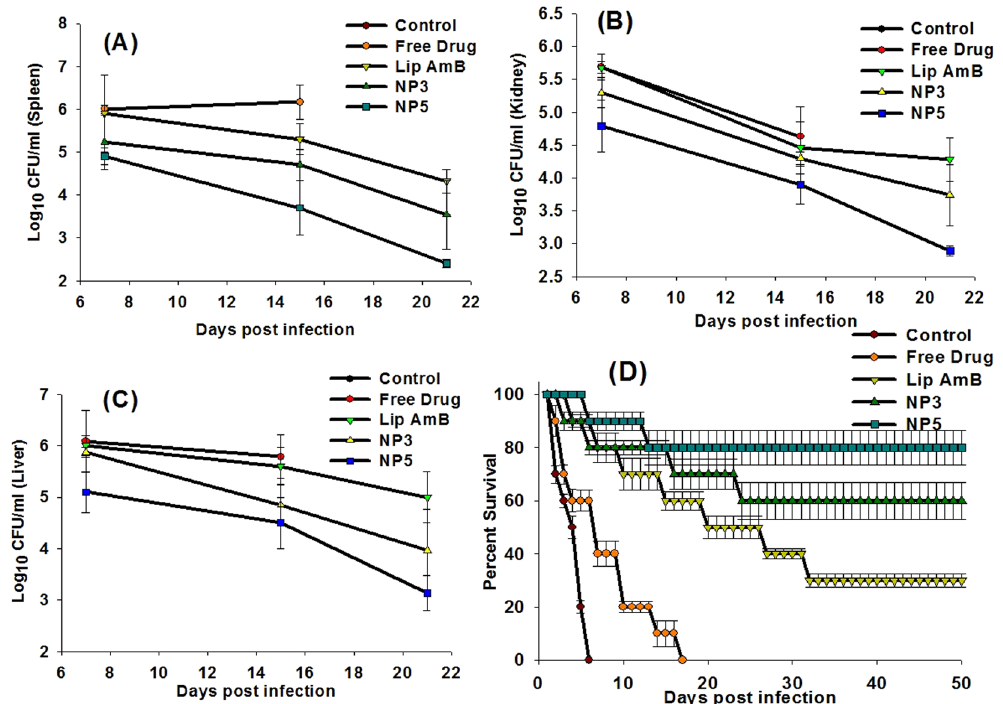
Figure 6. Potential of AmB-NA in treatment of systemic Candida albicans infection in experimental animals. Residual fungal load in the vital organs of experimental animals after treatment with AmB-NA formulation. ( A ) Fungal load in spleen. ( B ) Fungal load in Kidney ( C ) Fungal load in liver. [Group I versus Group III (p value < 0.001); Group I versus Group IV (p value < 0.001); Group I versus Group V (p value < 0.001); Group III (Lip-AmB) versus Group V (AmB-NA5) (p value < 0.05)]. ( D ) Survival rate of animals after exposure to infection followed by treatment with AmB-NAs. Group I versus Group III P value < 0.001; Group I versus Group IV P value < 0.001; Group I versus Group V P value < 0.001; Group III (Lip-AmB) versus Group V (AmB-NA5) P value <